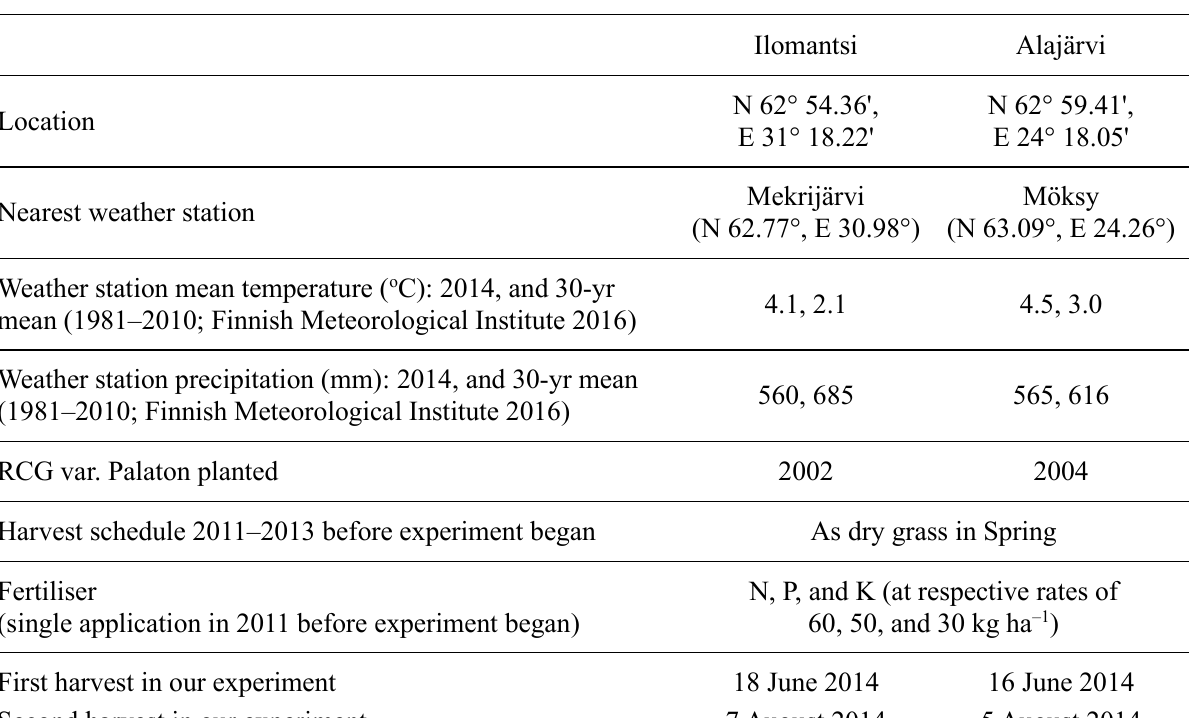
Table 1. Relevant characteristics of the two sampled